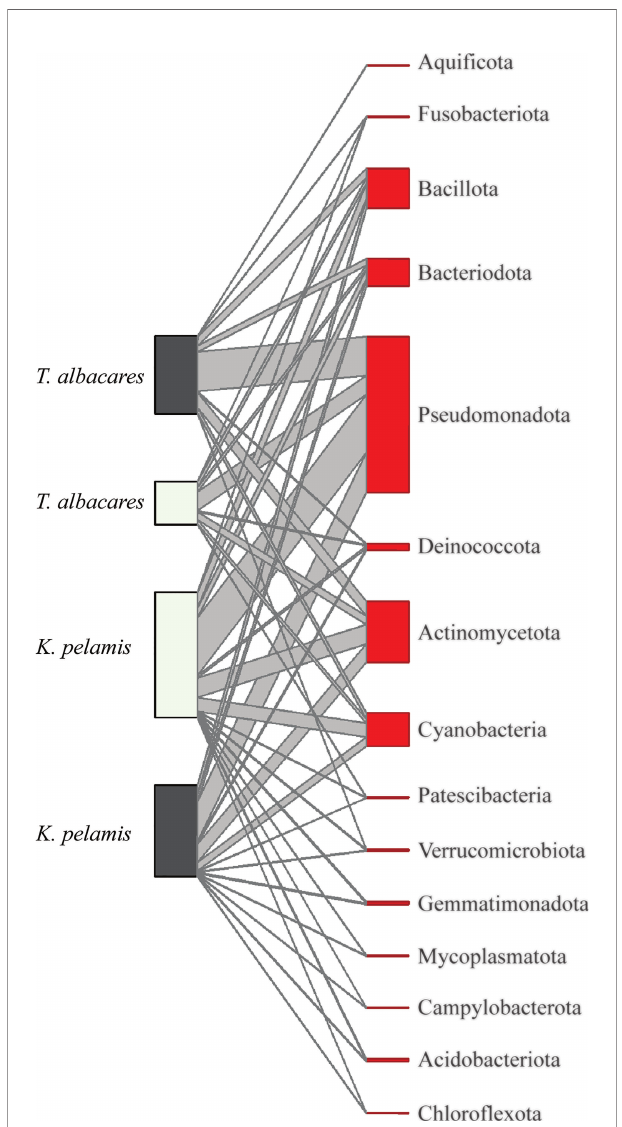
FIGURE 3 | Phylum level comparison of gut microbiome composition in Katsuwonus pelamis and Thunnus albacares captured during El Niño (dark grey) and La Niña (light grey) temperature oscillation events in 2015-2017. Operational Taxonomic Units (OTU) with less than 1,000 total reads were excluded from the analysis. Order and Family level comparisons can be found in Supplementary S5